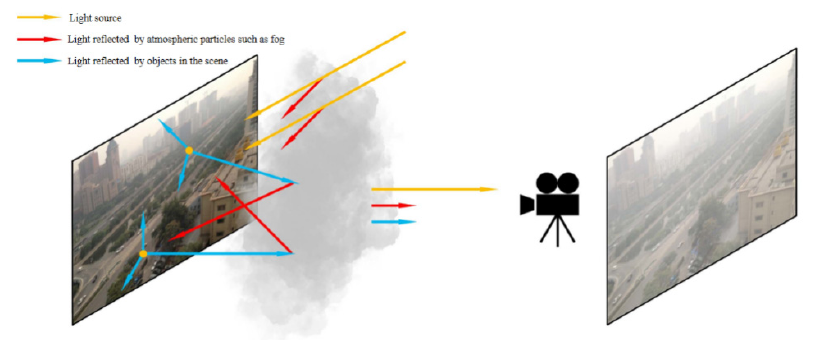
Figure 1. Imaging process under haze conditions.